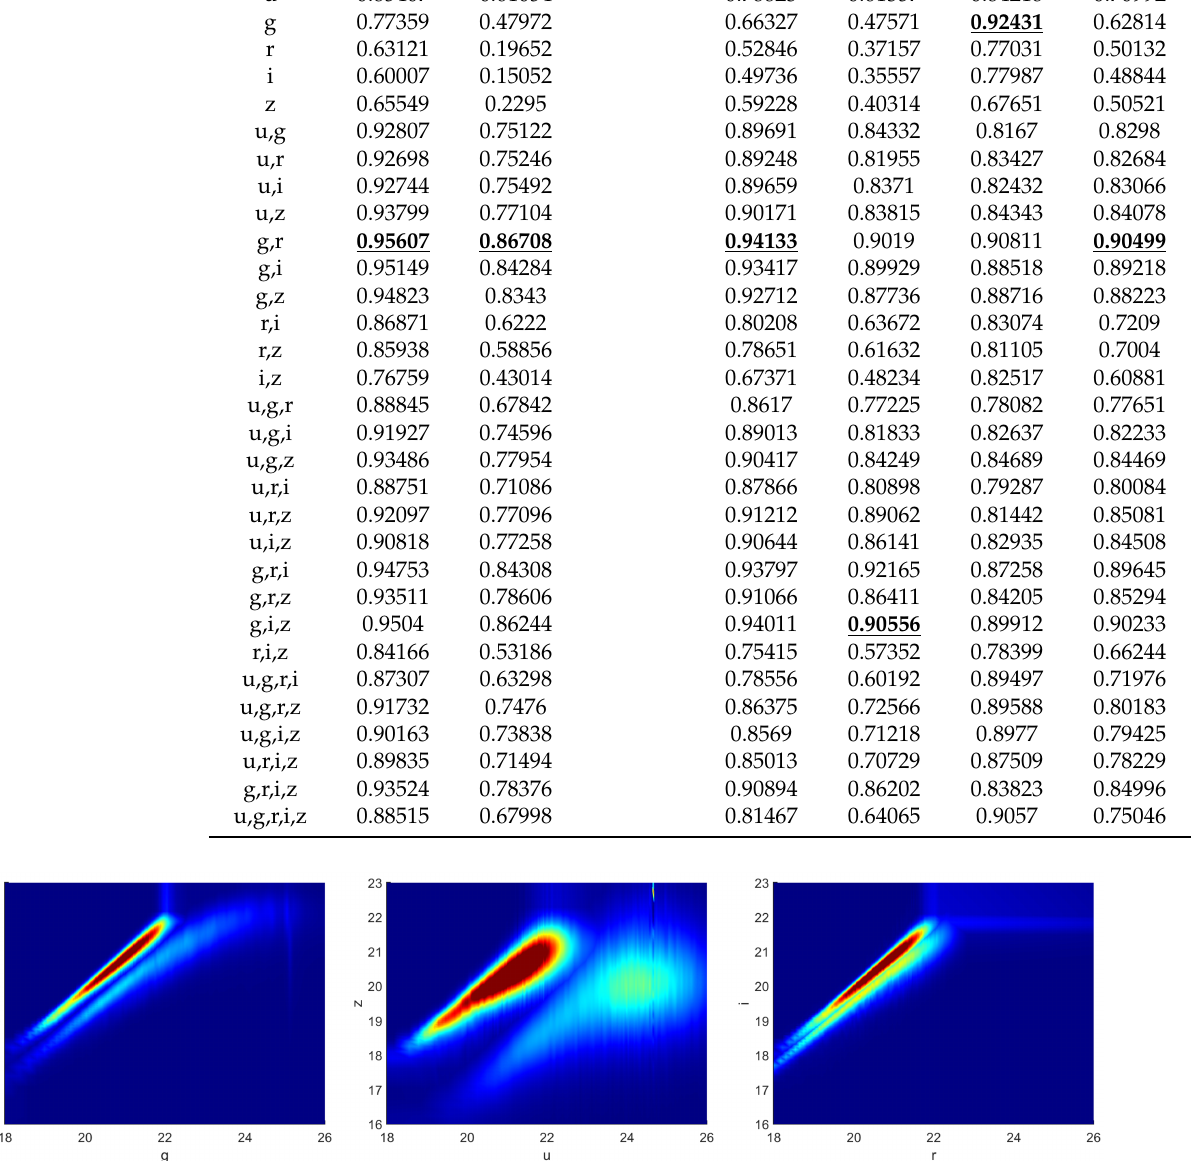
Figure 7. Two-dimensional surface plots showing relative densities for the g and r filters ( left ), u and z filters ( middle ), and r and i filters ( right ). The density of quasars are represented by the dark strips towards the top and the non-quasars are the lower density